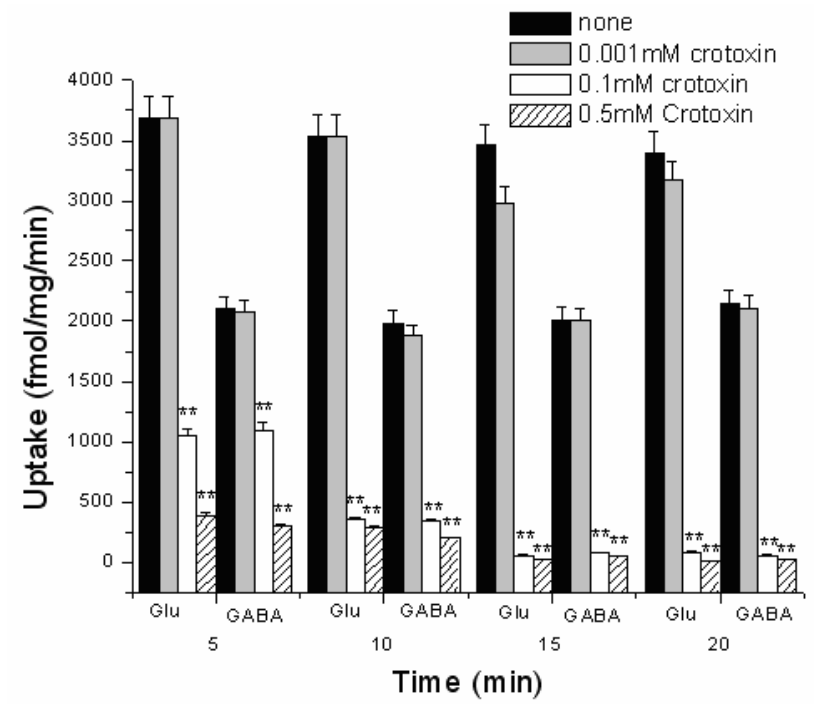
Figure 1. Inhibition of 3 H-L-glutamate and 3 H-GABA uptake by different crotoxin concentrations and incubation time in RCCS. Concentrations of 0.1 and 0.5 mM were effective (** p<0.01 ) in all periods